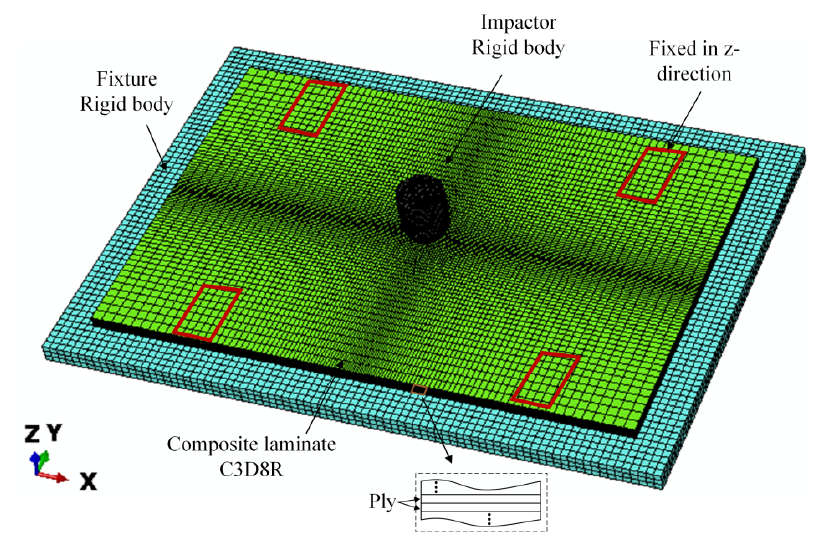
Figure 5. Finite element model of LVI experiments. Table 1. Material parameter for QI